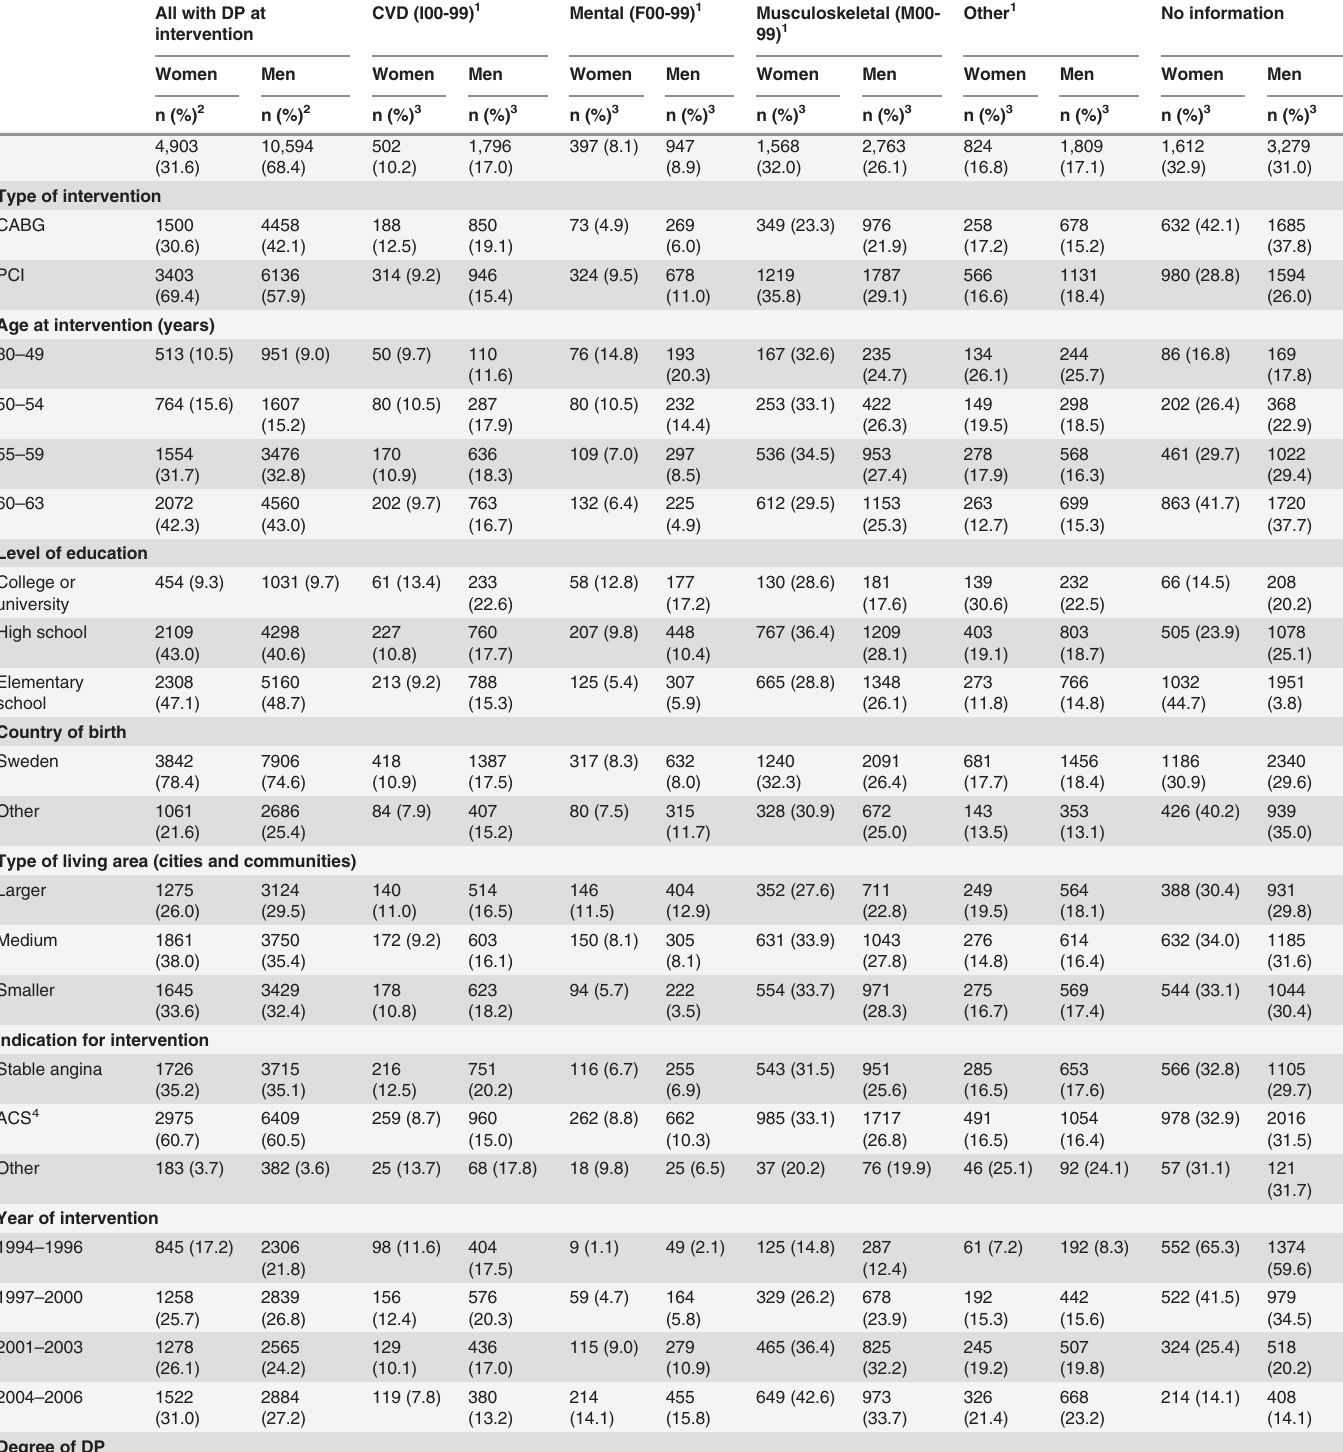
Table 2. Frequencies (n) and proportions (%) of disability pension (DP) diagnoses among women and men with a fi rst coronary revascularisation within the year 1994 – 2006 (n = 15,497). All with DP at